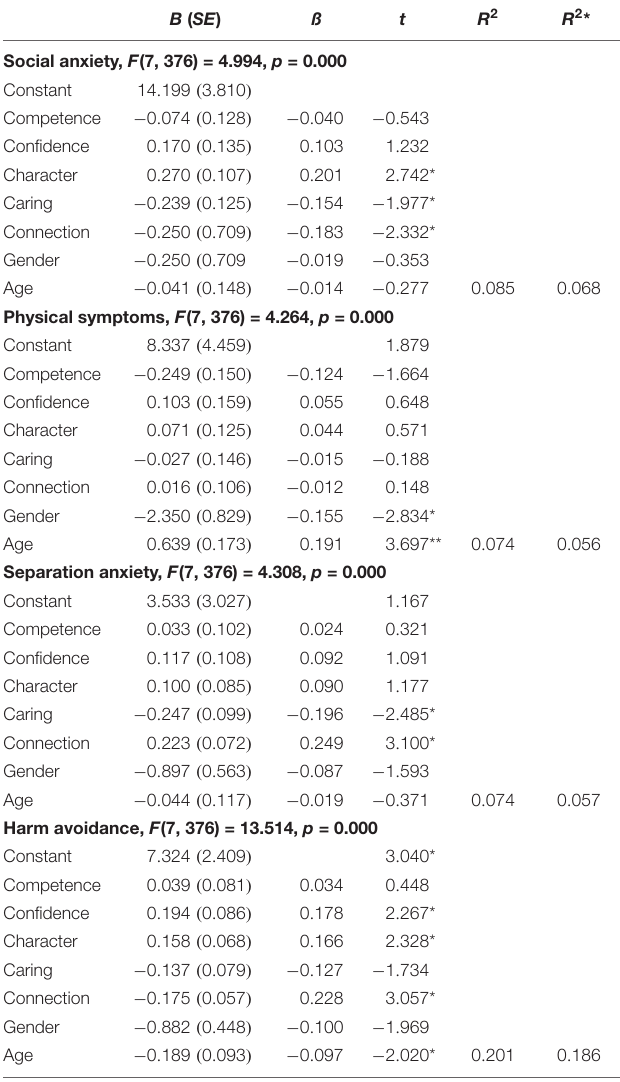
TABLE 2 | The predictive power of the 5Cs for the MASC components of anxiety in the Portuguese sample. B ( SE ) ß t R 2 R 2 *